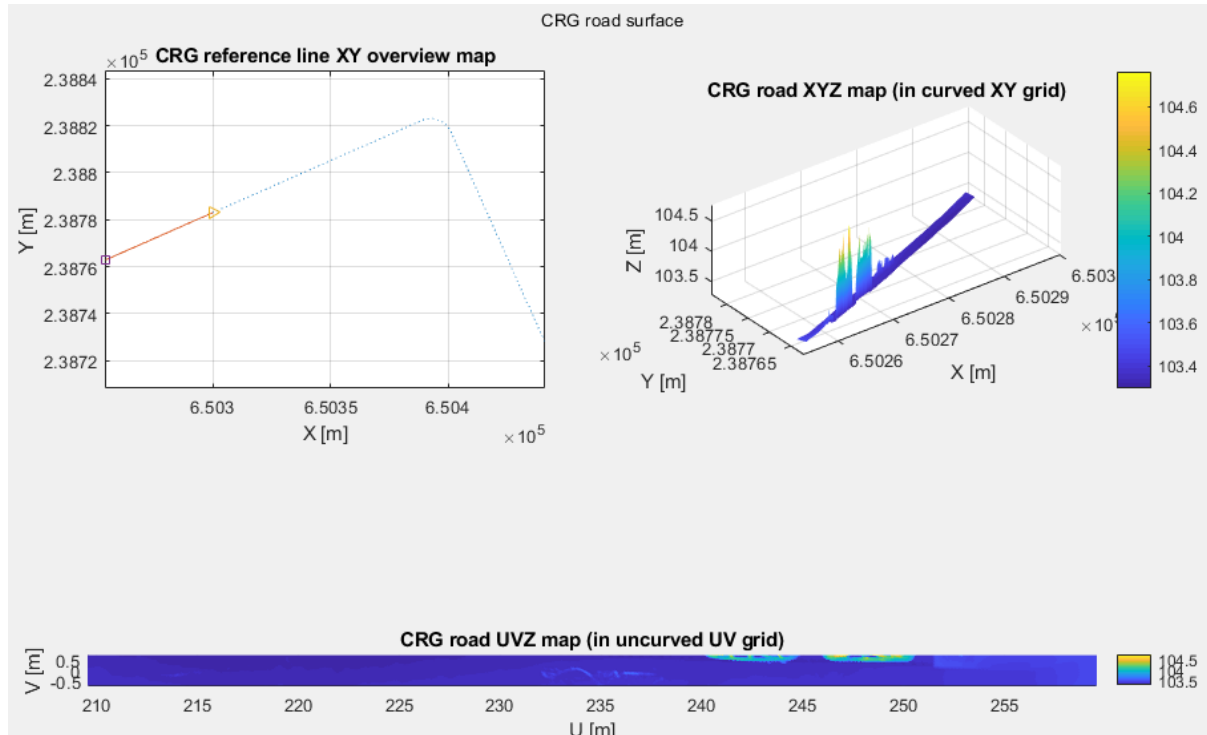
Figure 7. Example for the MLS pilot site visualization